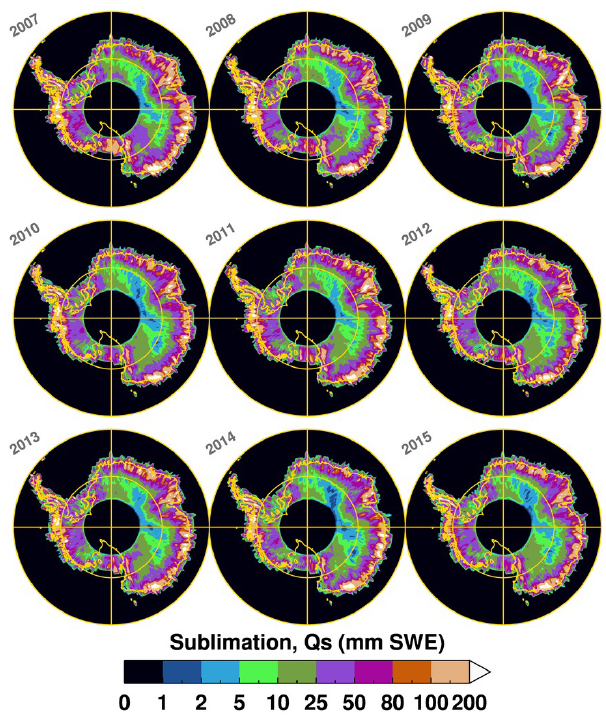
Figure 5. Blowing snow total sublimation over Antarctica by year for 2007–2015.